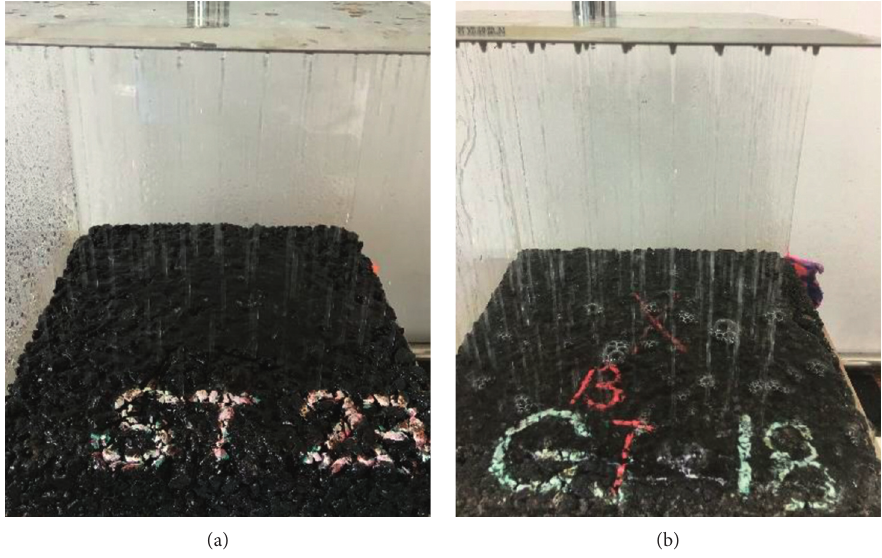
Figure 5: MDC measurement ((a) surface drainage; (b) surface